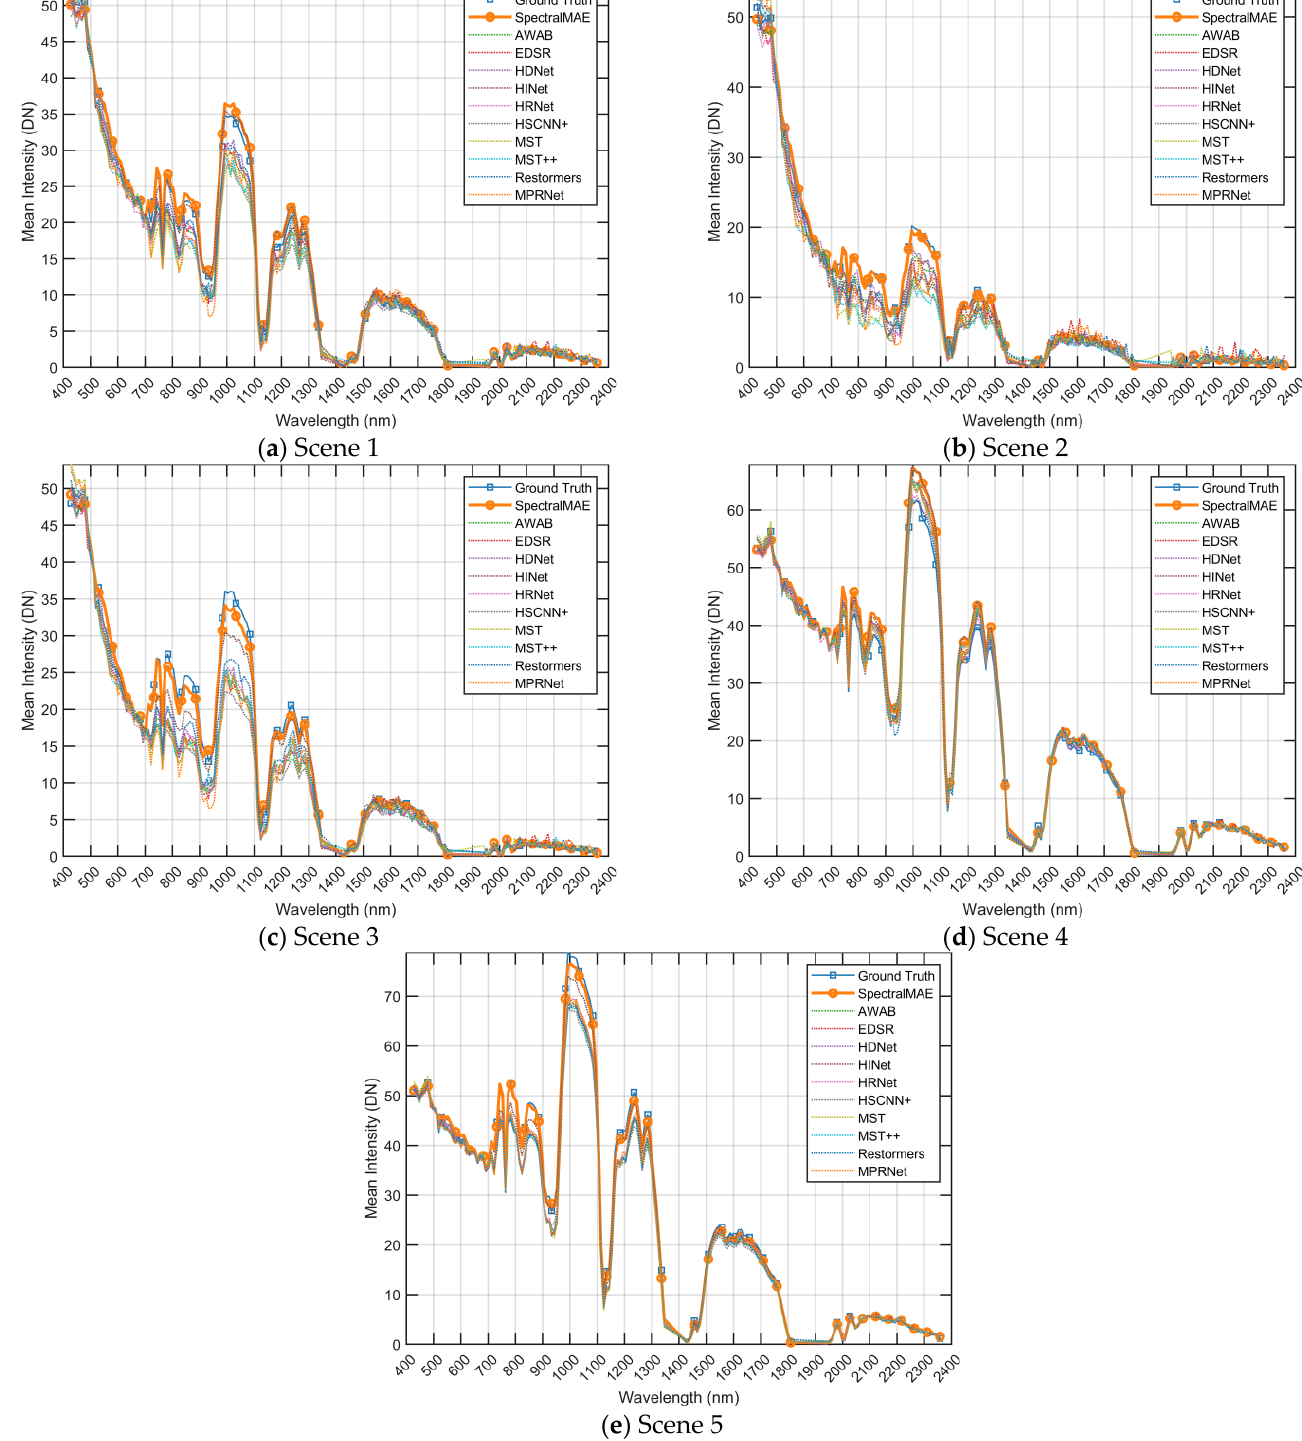
Figure 8. Reconstructed spectral curves comparisons of scenes shown in Figure 7 on the HyRANK dataset. The spectral curves were averaged in the spatial dimension of the images. DN is a digital number (uncalibrated) between 0 and 255.